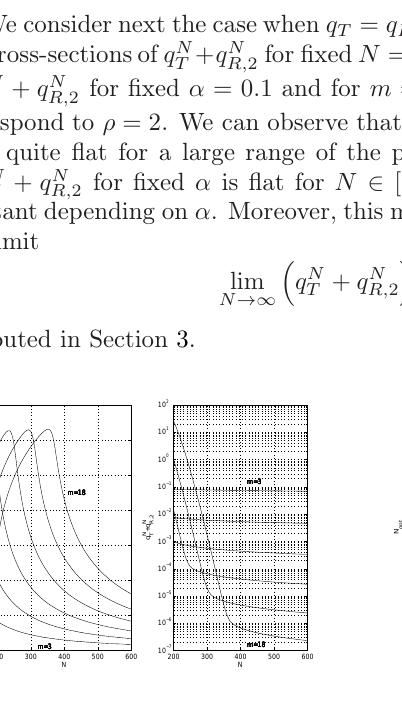
Figure 12. N opt versus α (left graph) and q N q N α (right graph) for ρ = 2 T + R, 2 versus and m = 3 , 6 , 9 , 12 , 15 and 18